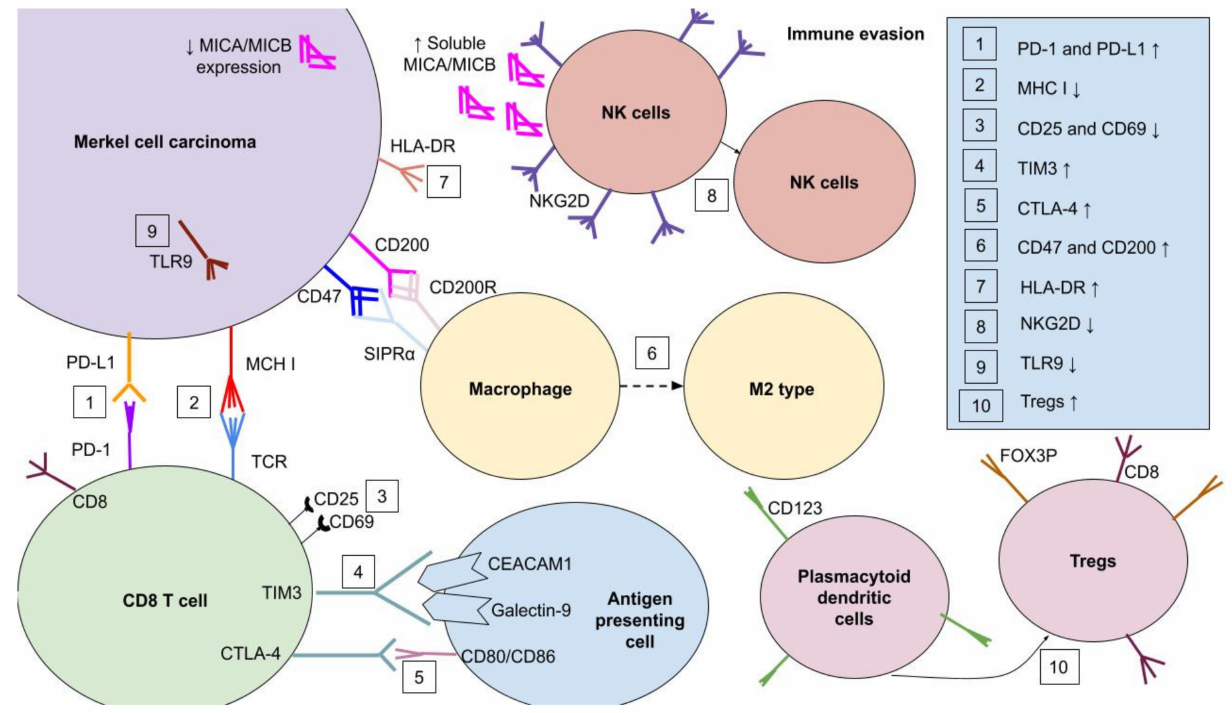
Figure 5. Merkel cell carcinoma immune evasion. To evade host immune response, MCC cells increase PD-L1, CD47, CD200, and HLA-DR expression. Boosted PD-1/PD-L1, CTLA-4/CD80, or CD86 and TIM3/CEACAM1 or galectin-9 interactions as well as decreased MCH1/TCR one result in immunosuppression. Overexpression of CD47 and CD200, promoting M2 macrophage polarization. In MCC cells, MICA/MICB and TLR9 expression is downregulated. Higher soluble MICA/MICB concentration causes NKG2D internalization and suppresses NK cell activity. Reduced expression of CD69 and CD25, which are the markers of T-cell activation, is observed. Moreover, the proliferation of CD8+FOX3P+ Tregs is promoted by CD123+ plasmacytoid dendritic cells, which are located within the MCC